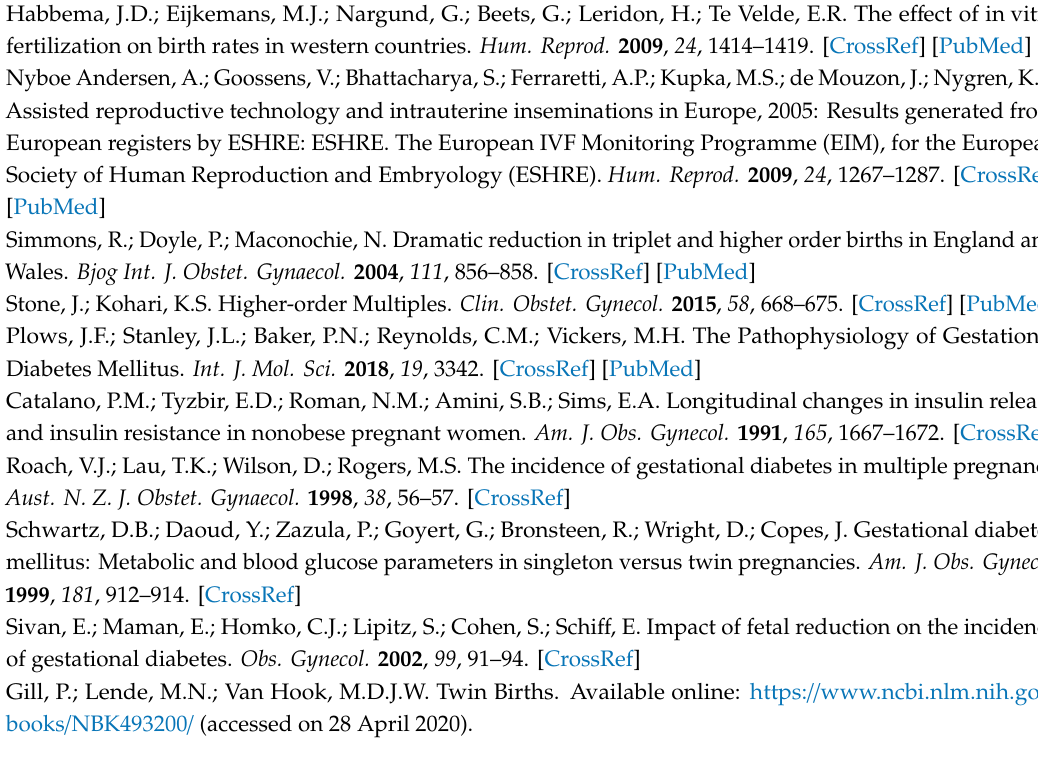
Table S1: Estimates and 95% confidence intervals obtained in a leave-one-out sensitivity analysis of all 38 eligible studies. The calculations are performed as in the main analysis. However, in each round of the sensitivity analysis one study is not included; Table S2: Estimates and 95% confidence intervals obtained in a leave-one-out sensitivity analysis of all 11 studies with a sound GDM definition. The calculations are performed as in the main analysis. However, in each round of the sensitivity analysis one study is not